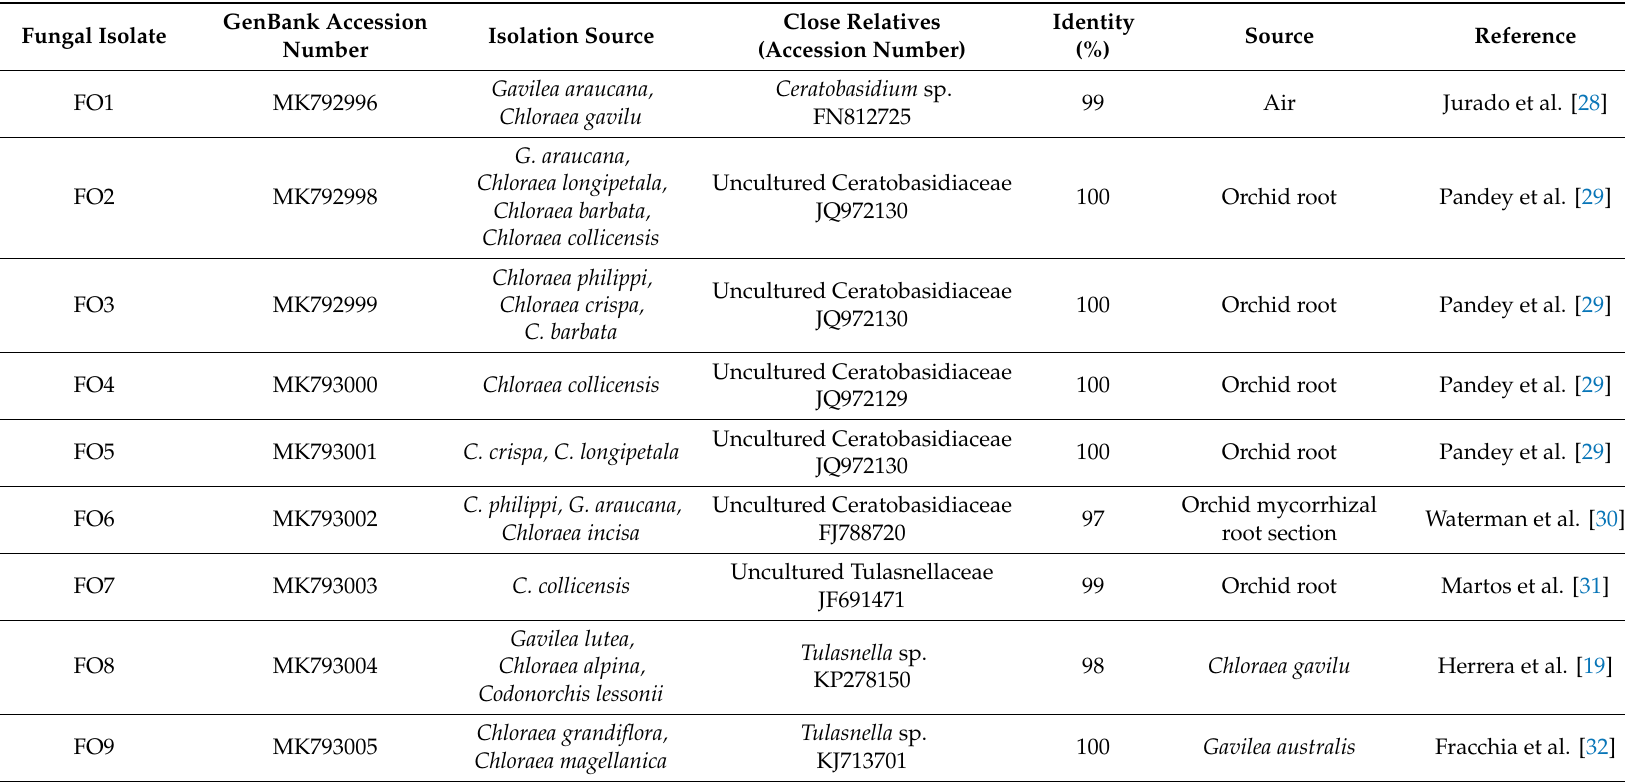
Table 3. Molecular identification of culturable mycorrhizal fungi isolated from peloton-containing roots, based on the closest match in the GenBank database. Fungal